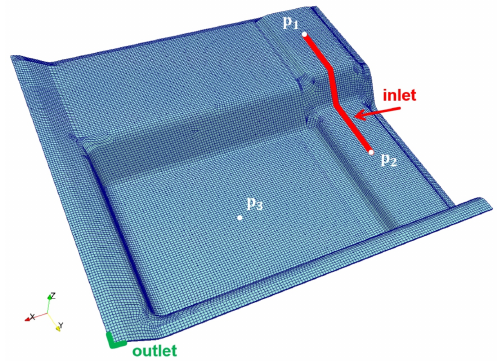
Figure 9. Simulation model of the complex part with the location of inlet, outlet and three pressure